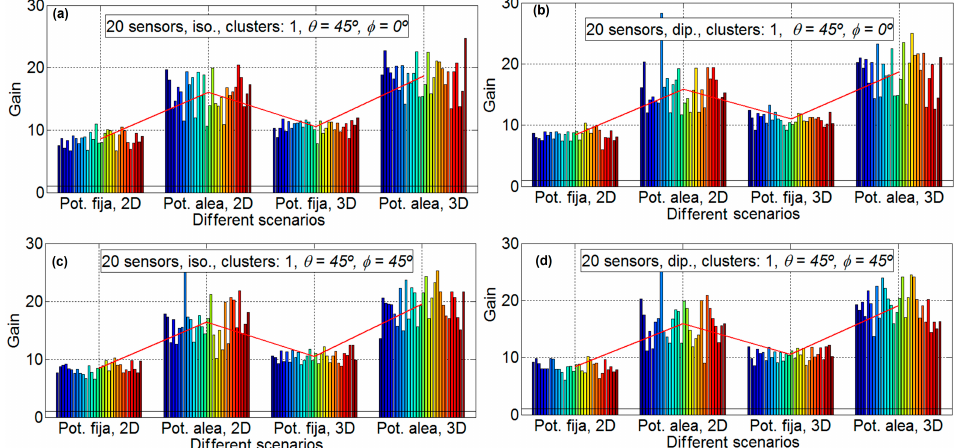
Figure 5. Gain results for 20 sensors. Isotropic ideal antenna, φ = 0 ◦ and θ = 45 ◦ in subfigure ( a ) ( upper left ), dipole antenna, φ = 0 ◦ and θ = 45 ◦ in subfigure ( b ) ( upper right ), isotropic ideal antenna, φ = 45 ◦ and θ = 45 ◦ in subfigure ( c ) ( lower left ) and dipole antenna, φ = 45 ◦ and θ = 45 ◦ in subfigure ( d ) ( lower right ).